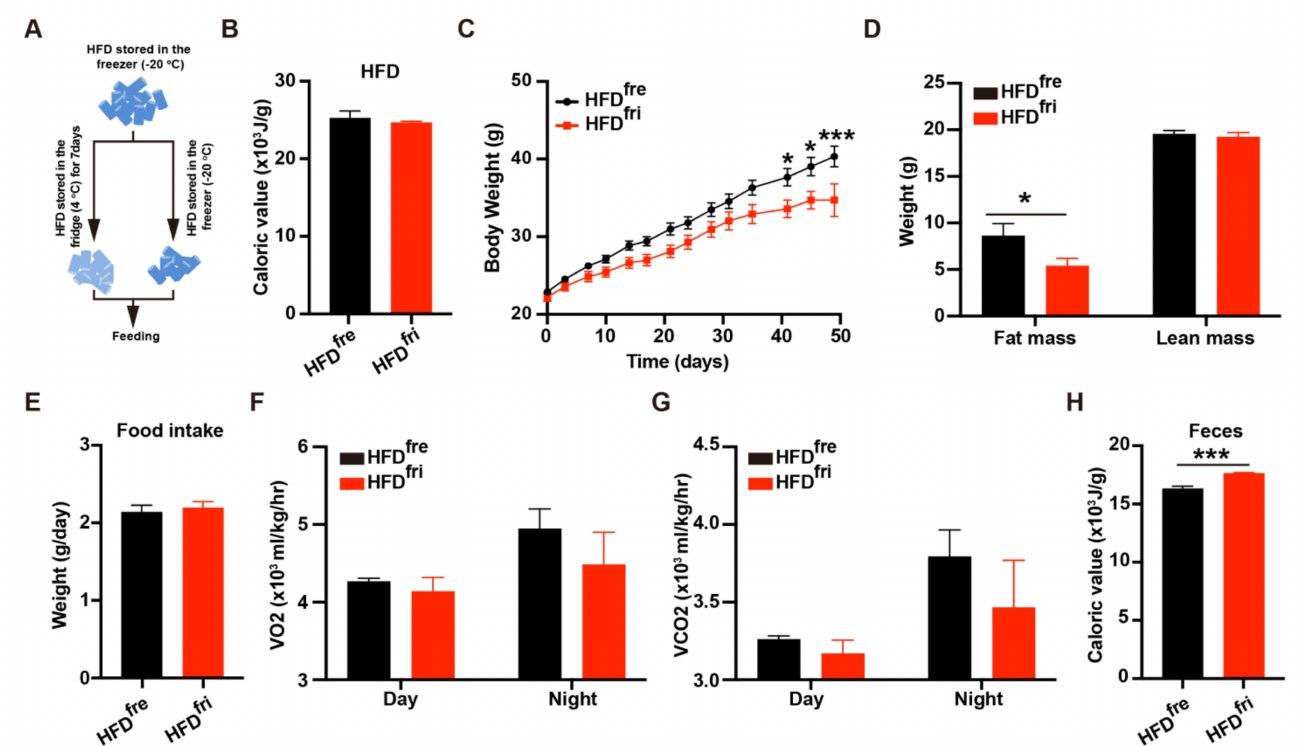
Figure 1. High-fat diets (HFDs) stored in different conditions leads to bodyweight differences. ( A ) The simplified protocol for high-fat diet (HFD) storage. HFDs were divided into two parts. HFDs stored in the freezer (fre) (HFD fre ) were stored at − 20 ◦ C for 7 days, and HFDs stored in the fridge (fri) (HFD fri ) were stored at 4 ◦ C before the experiments started; ( B ) the bomb calorimeter was used to detect the energy content in HFD fre and HFD fri (HFD fre , n = 5; HFD fri , n = 6); ( C – G ) analysis of metabolic features of the mice. The features include ( C ) body weight ( p < 0.0001 from two-way ANOVA) (n = 9 for each group), ( D ) body composition (n = 10 for each group), ( E ) food intake (n = 9 for each group), ( F ) average O 2 consumption rate (VO2, p = 0.2766 from two-way ANOVA) (n = 4 for each group), and ( G ) average CO 2 production rate (VCO2, p = 0.2650 from two-way ANOVA) (n = 4 for each group); ( H ) fecal energy content of mice fed by HFDs stored in different conditions (n = 5 for each group). The adjusted p -value from multiple comparison tests are indicated as *, p < 0.05; ***, p < 0.001. The results of the Student t -test are provided in Supplementary Table